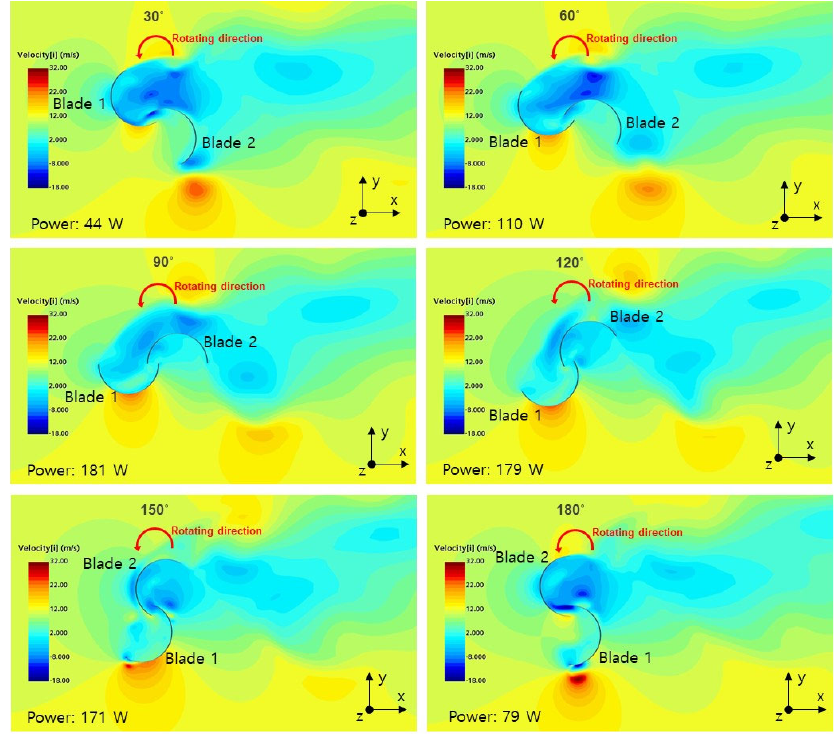
Figure 12. Velocity distribution according to rotor rotation position.